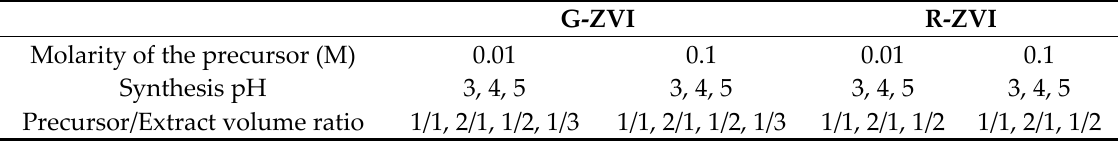
Table 1. Experimental matrix for synthesis optimization of iron nanoparticles.